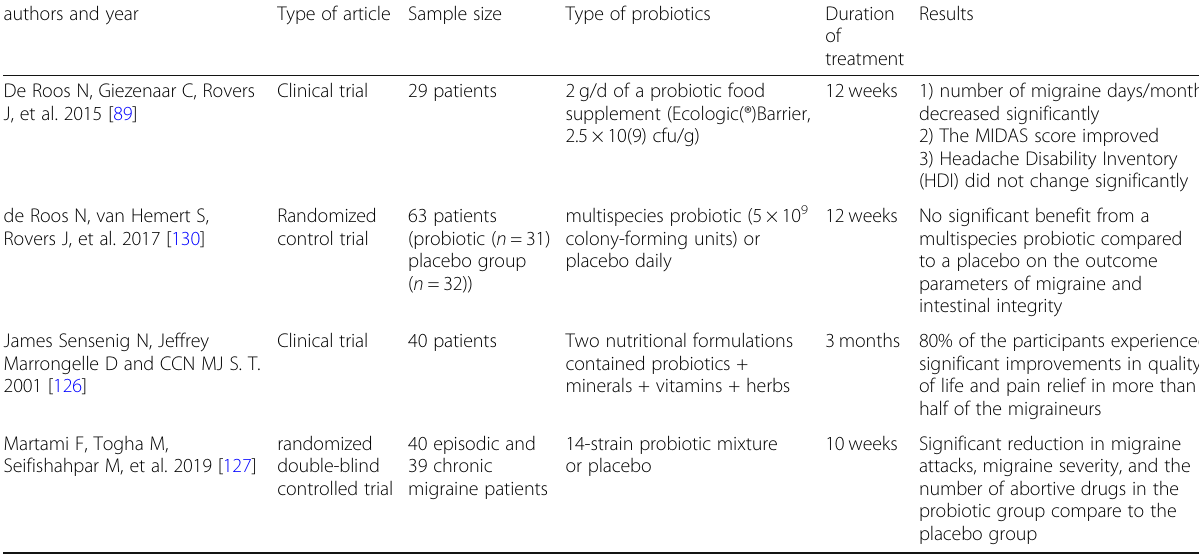
Table 1 Literatures on effects of probiotic supplementation on migraine headache authors and